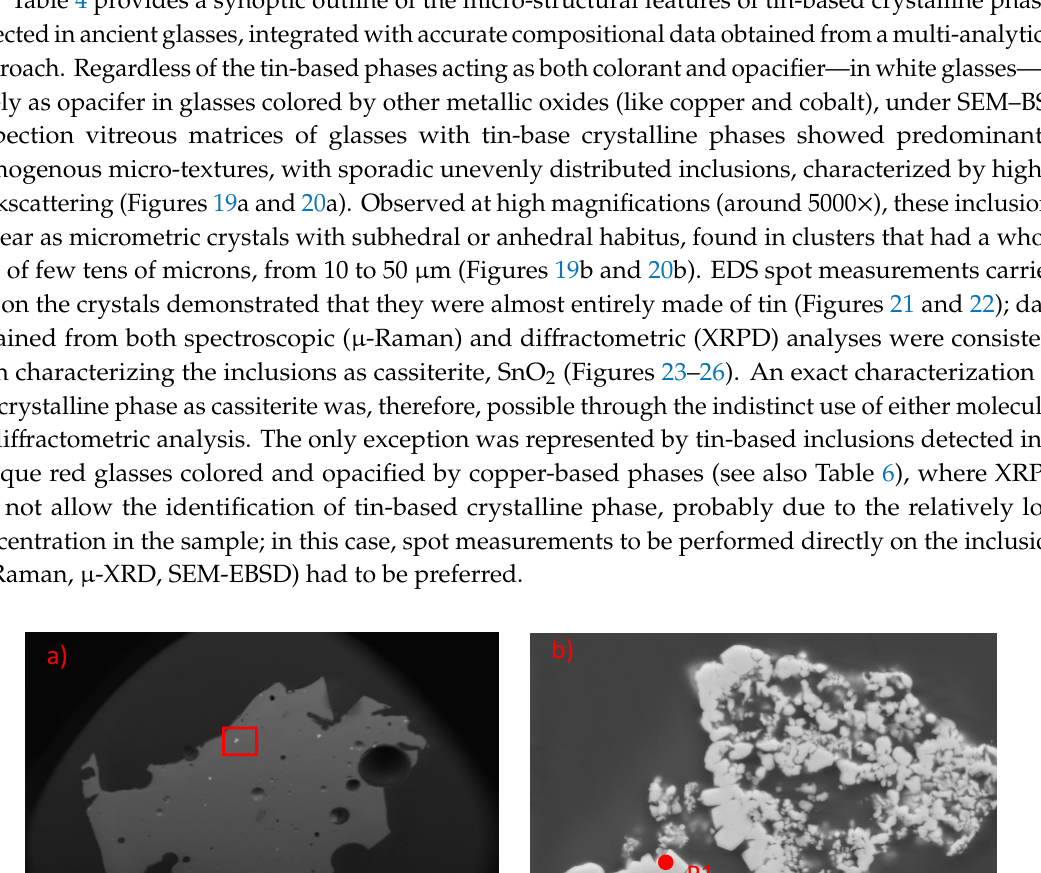
Table 4. Tin-based phases.